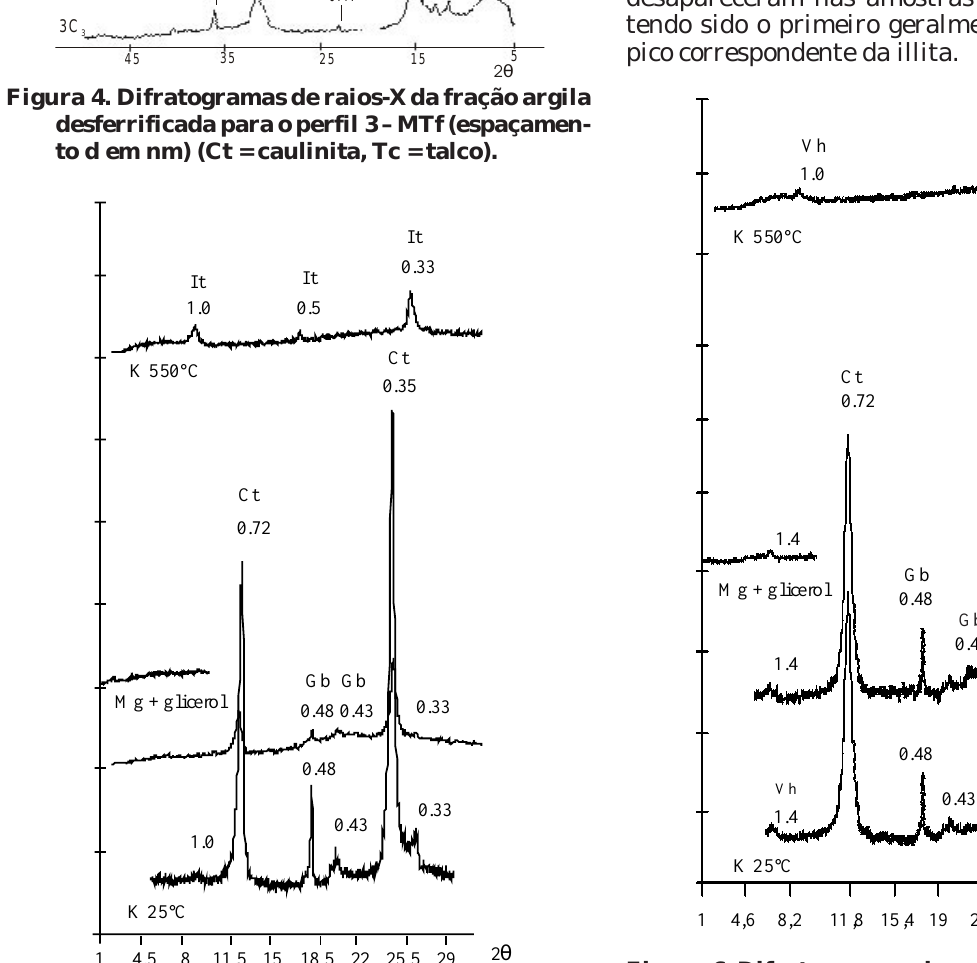
Figura 6. Difratogramas de raios-X da amostra 2A (Perfil 2 – PVe) com os diversos tratamentos. Espaçamento d em nm (Vh = vermiculita com hidróxi entrecamadas, Ct = caulinita, Gb =